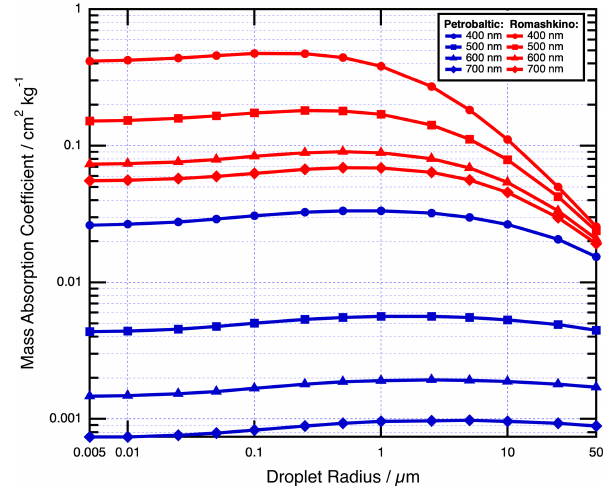
Figure 4. Mass absorption coefficient of Romashkino and Petrobaltic oils with peak droplet radii between 0.005–50µm. The geometric standard deviation size was set to e 1 to represent a mid- range value for the particles studied here. These data demonstrate the mass absorption coefficient of Romashkino and Petrobaltic oil peak at different droplet sizes and different